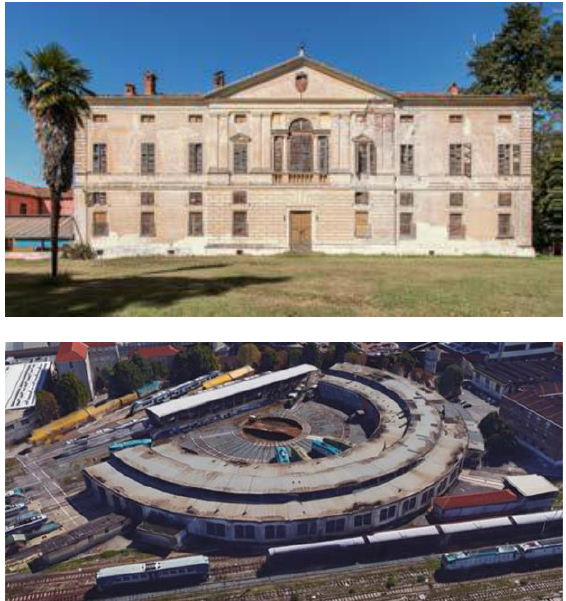
Figure 1. Palazzo Sarmatoris (above) and the Smistamento Roundhouse